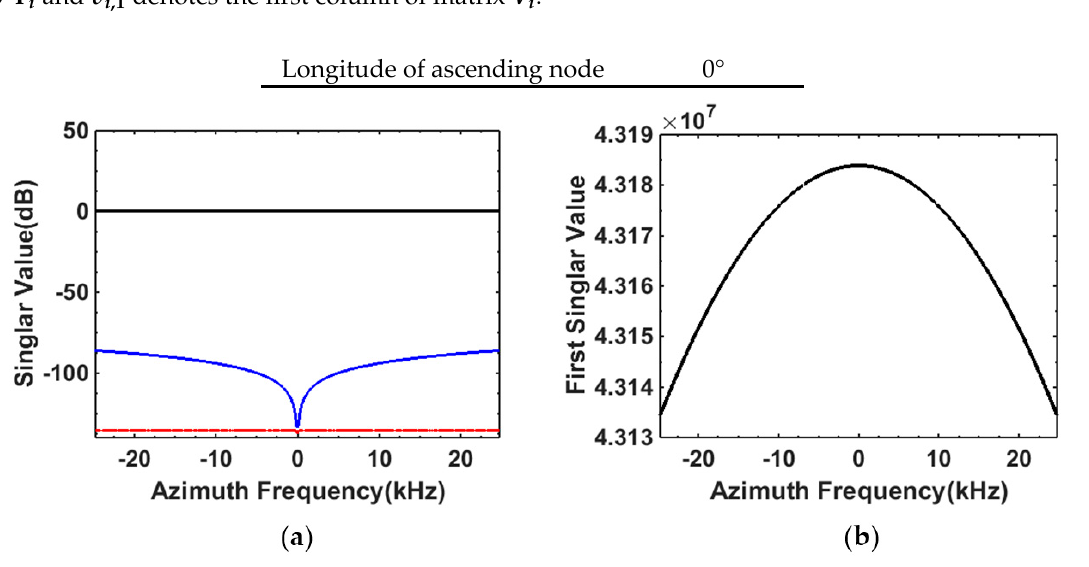
Figure 2. Demonstration of singular values. ( a ) First three singular values in decibels; ( b ) First singular values.